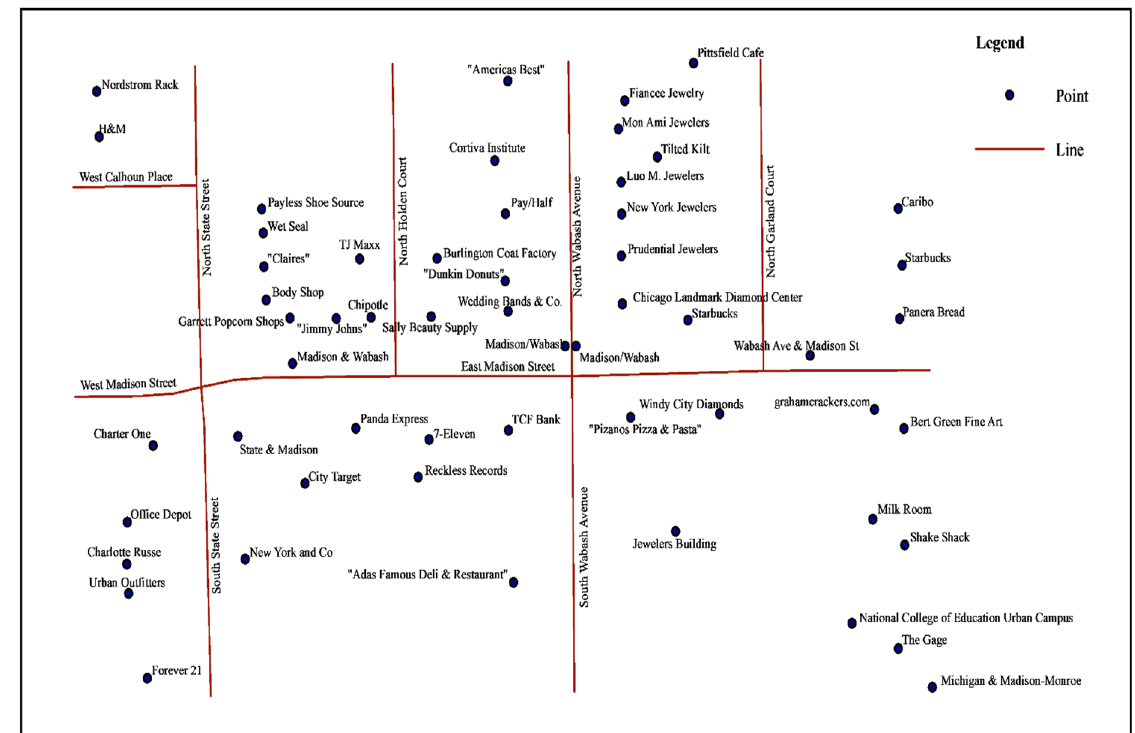
Figure 10. Result of the second dataset using the DDEGA-NM algorithm.